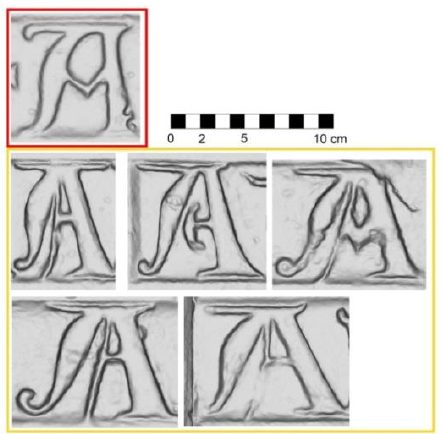
Figure 8. Table of A s, red frame: 19 th century, yellow frame: medieval